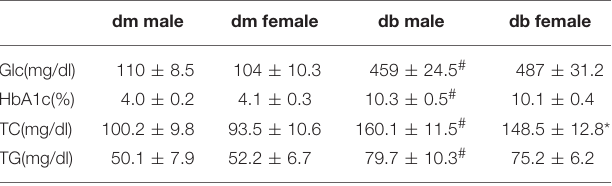
TABLE 1 | Concentrations of blood glucose and lipids in diabetic and non-diabetic